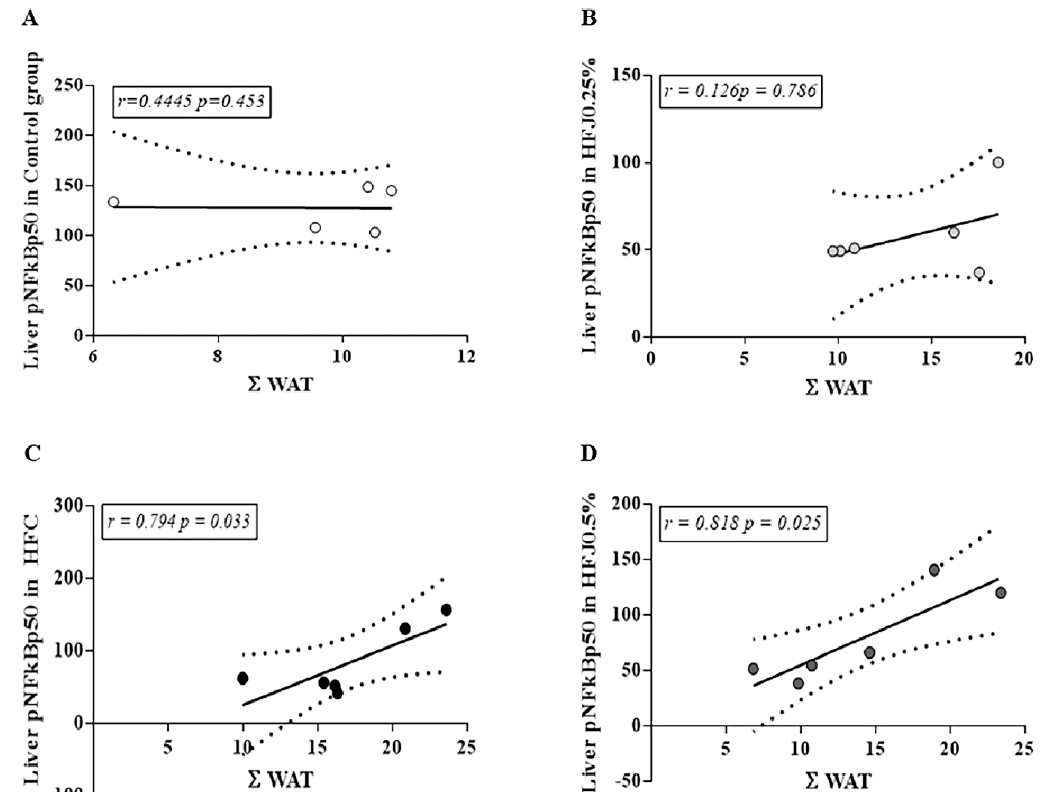
Figure 6. Correlation between Σ WAT and pNF κ Bp50 in liver for different experimental groups: ( A ) Control standard chow group (control); ( B ) high-fat diet juçara 0.25% (HFJ0.25%); ( C ) high-fat diet control group (HFC); ( D ) high-fat diet juçara 0.5% (HFJ0.5%). The Pearson correlation coefficient was performed considering the level of significance as p < 0.05 and the Pearson’s r- value > 0.7 for a strong correlation.